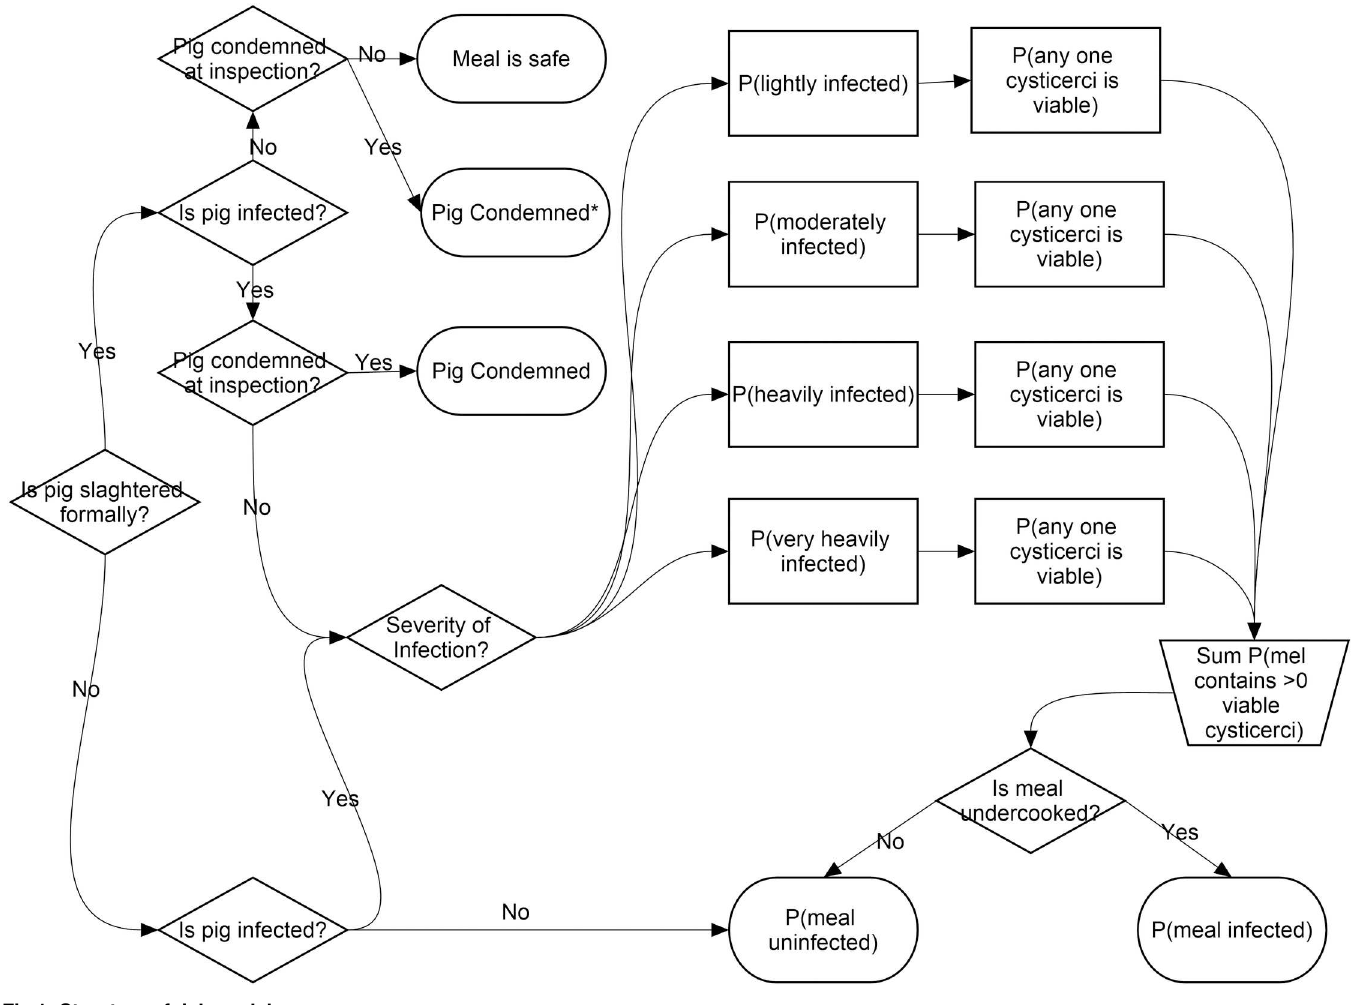
Fig 1. Structure of risk